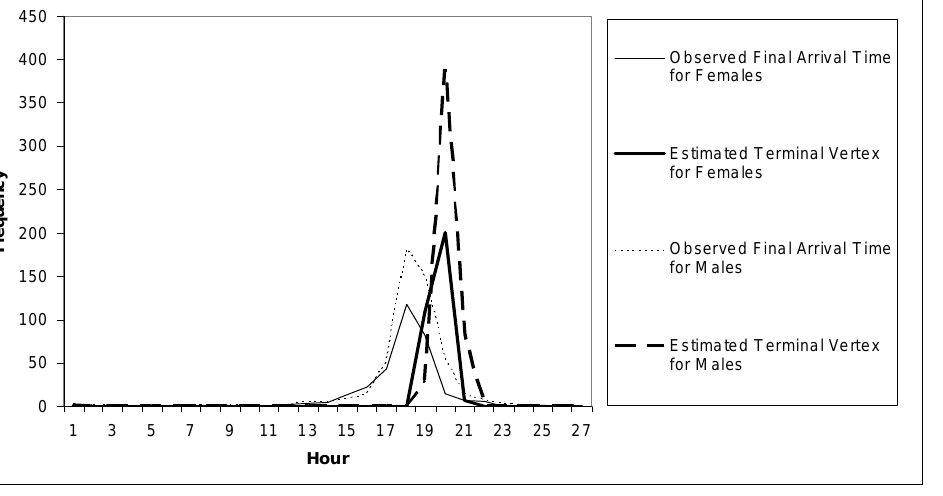
Figure 5. Distribution of estimated terminal vertex location and final arrival at home for female and male workers, of activity pattern with no out-of-home activities after in-home